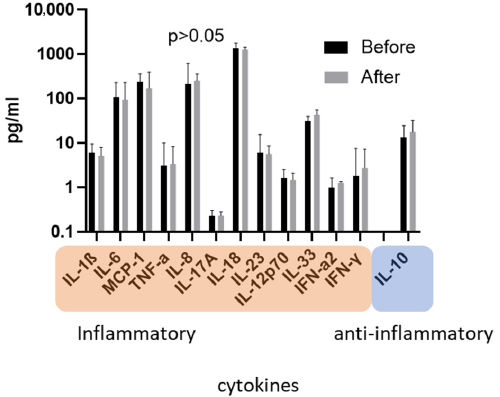
Figure 3. Concentrations of inflammatory and anti-inflammatory cytokines of blood samples taken from ACLF patients before and after ADVOS treatment as assessed by a cytometric bead array (median concentration, error bars indicate IQR).